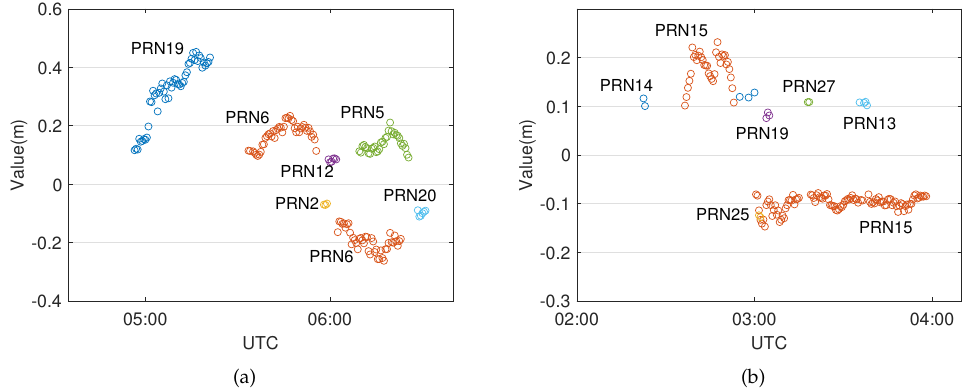
Figure 10. Values of the estimated additional parameters of ( a ) Event 1 and ( b ) Event